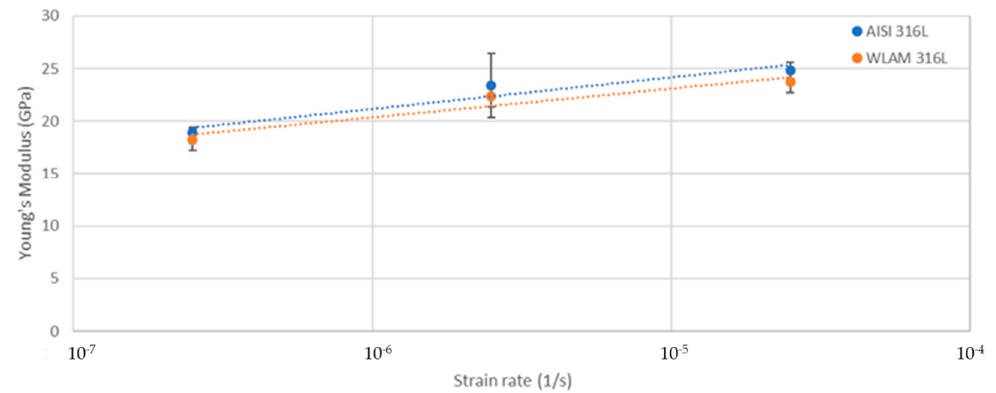
Figure 11. Young’s modulus vs. strain rate of the WLAM samples and counterpart AISI 316L alloy.